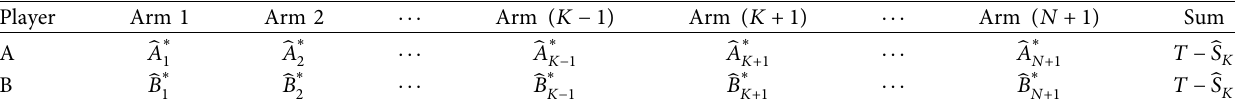
Table 2: Preference setting followed by the remaining part of the joint selection probability matrix in the gray-shaded region. 􏽢 A ∗ 􏽢